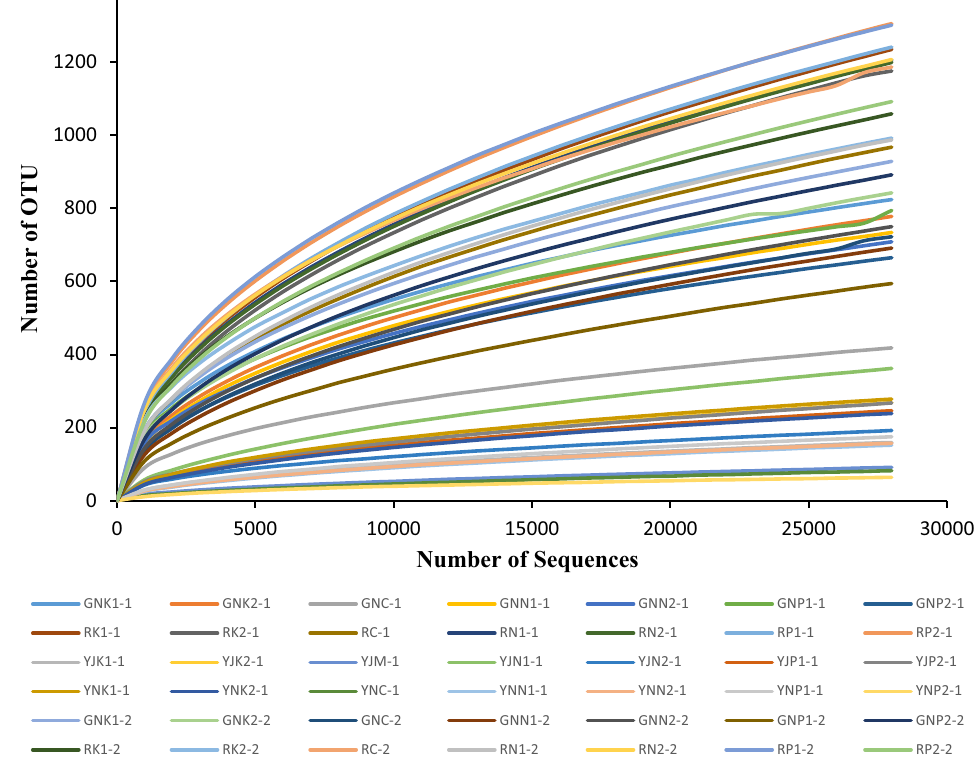
Figure 5. Dilution curve of bacterial 16S gene sequence. (“GN” indicates bacteria in roots, “R” indicates bacteria in rhizosphere, “YJ” indicates bacteria in phyllosphere, “YN” indicates bacteria in leaf, the same